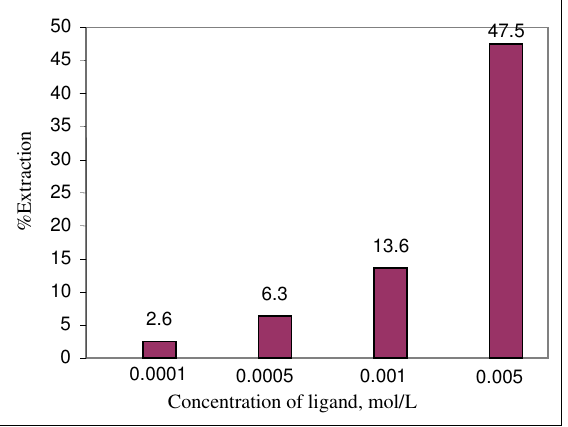
Figure 1. Effect of the ligand on the competitive extraction of